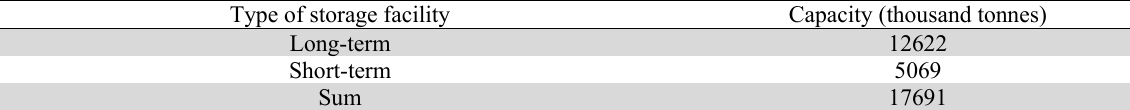
Capacity of storage facilities